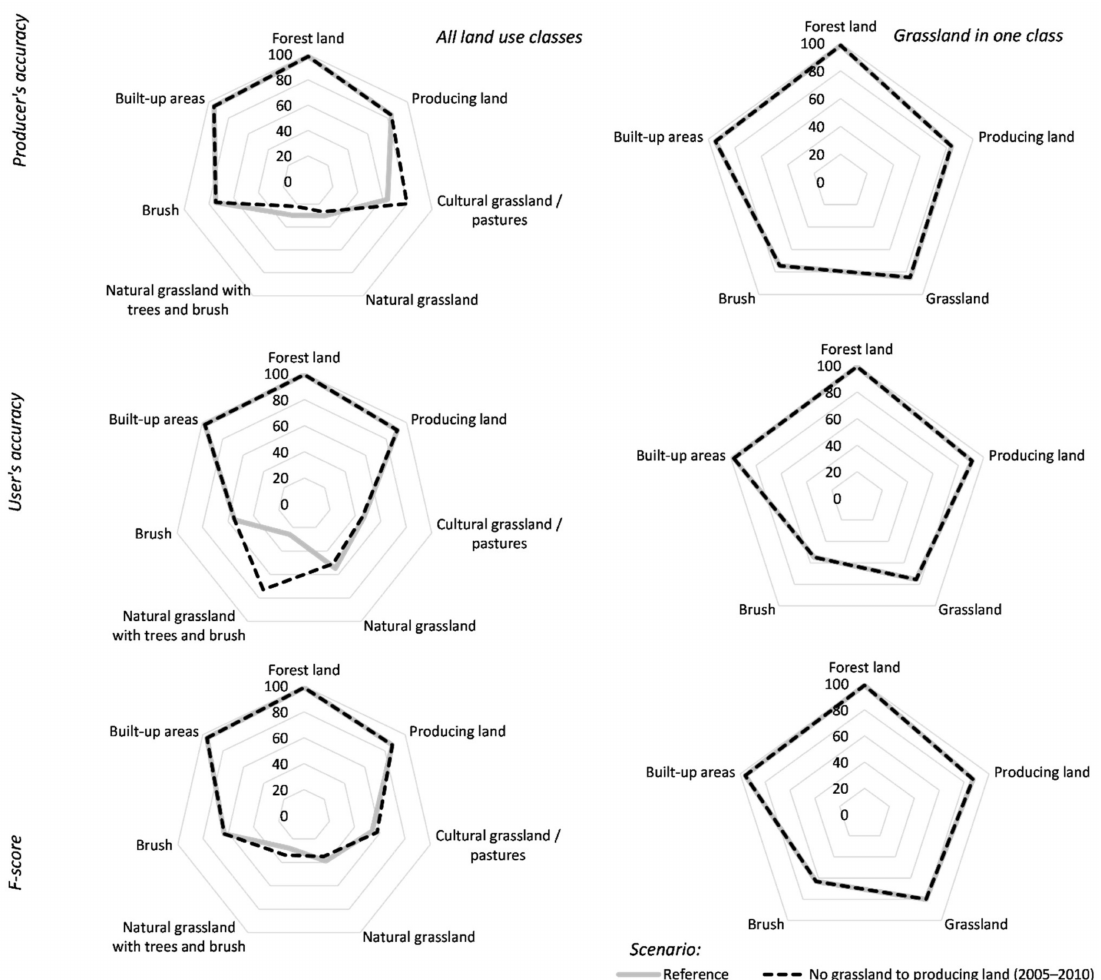
Figure 4. Predicting accuracy of some of the most encountered land uses, achieved using a strategy of driver variable selection based on optimization.